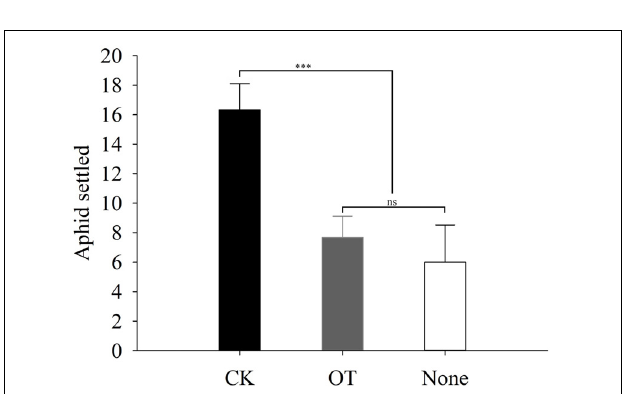
FIGURE 3 | Flight behavior of the winged aphid on β -ocimene-treated and control Chinese cabbages. O, purified β -ocimene. OT, β -ocimene treated Chinese cabbage. None, no choice. Different letters over the bars designate a significant difference: ∗ P < 0.05, ∗∗ P < 0.01, ∗∗∗ P <